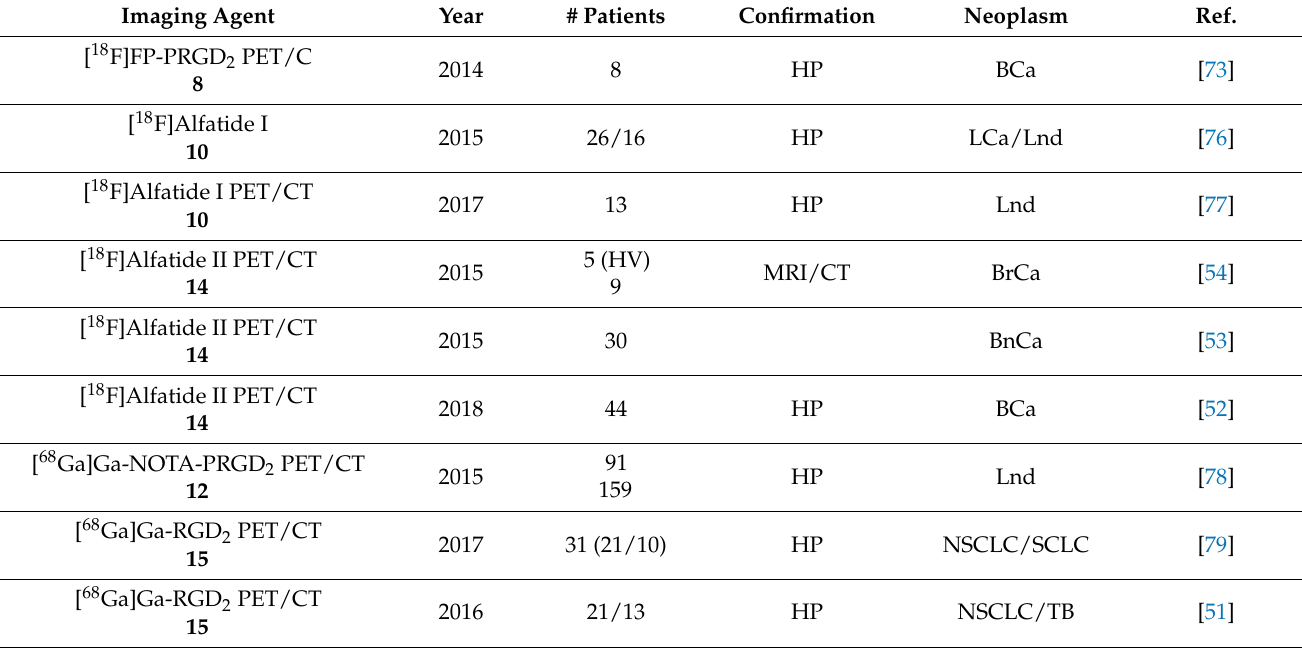
Table 1. Clinical studies with multimeric c(RGD)